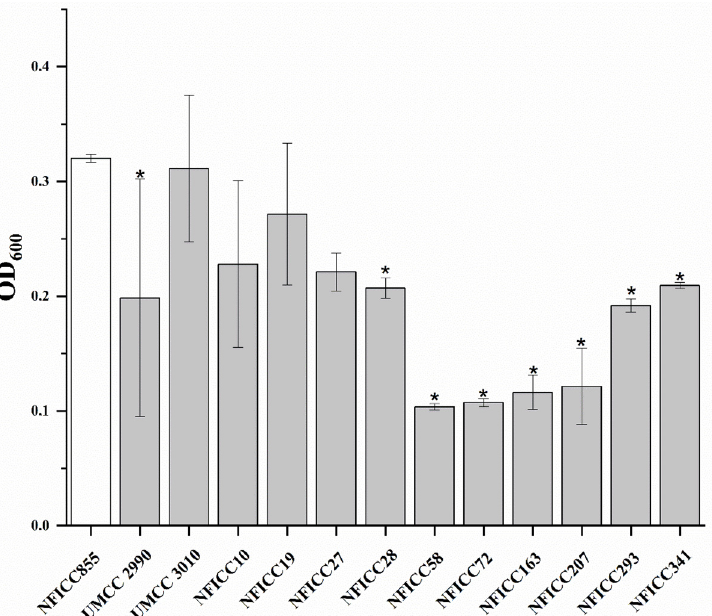
Figure 3. Antibacterial activities of the selected LAB’s cell-free supernatant in Bread Media (BM) against spoilage agents B. weihenstephanensis NFICC855. One-tail t test was performed on the obtained triplicates comparing OD 600 value after 48 h growth of NFICC855 in BM and the same pathogens challenged with CFS of L. plantarum (NFICC19, 27, 72, 207, and 293), F. sanfranciscensis (UMCC 2990), Lc. citreum (NFICC28), and P. pentosaceus (UMCC 3010, NFICC 58, and 341). The mean value of the samples represented by * was significantly lower than the control sample (untreated sample); t(2) = − 2.92 and p = 0.05.